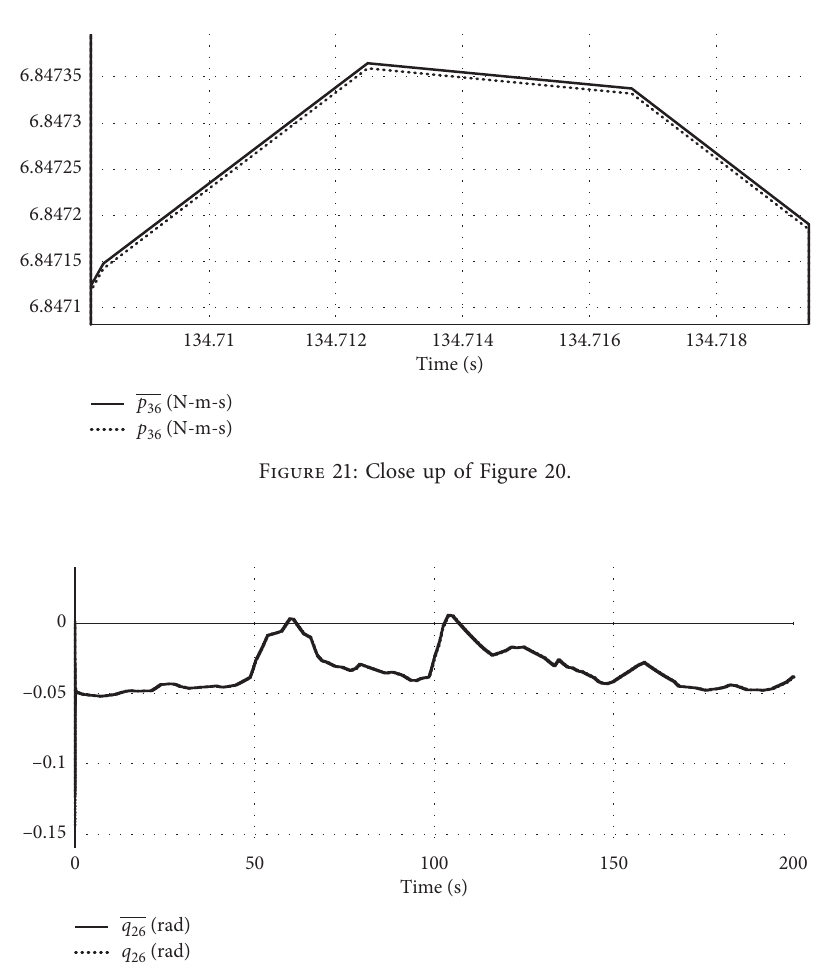
Figure 22: Full-time simulation of the slow variable q